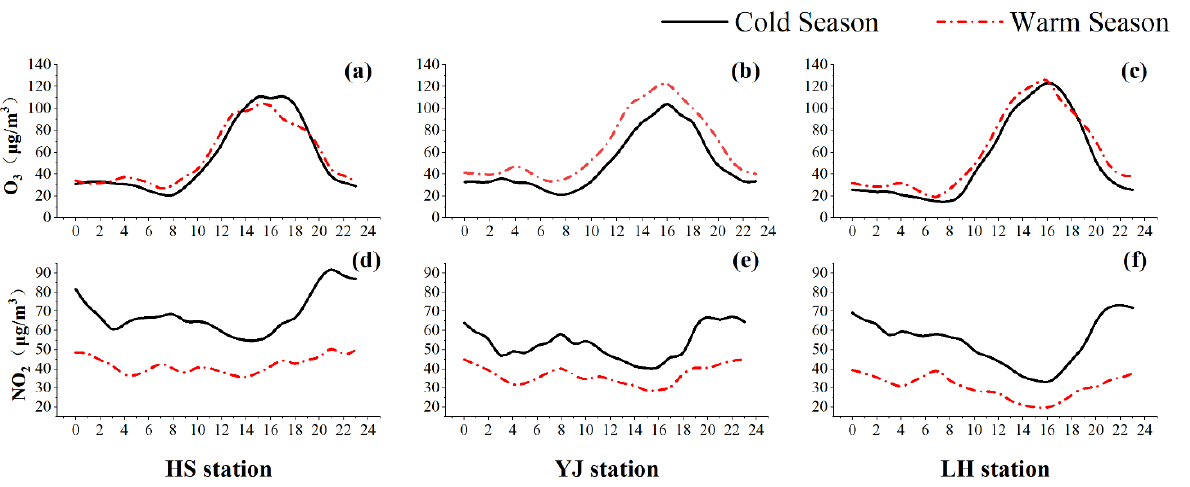
Figure 2. Diurnal variation of typical pollutants in cold and warm seasons: O 3 concentrations at ( a ) HS station, ( b ) YJ station, and ( c ) LH station; NO 2 concentrations at ( d ) HS station, ( e ) YJ station, and ( f ) LH station.